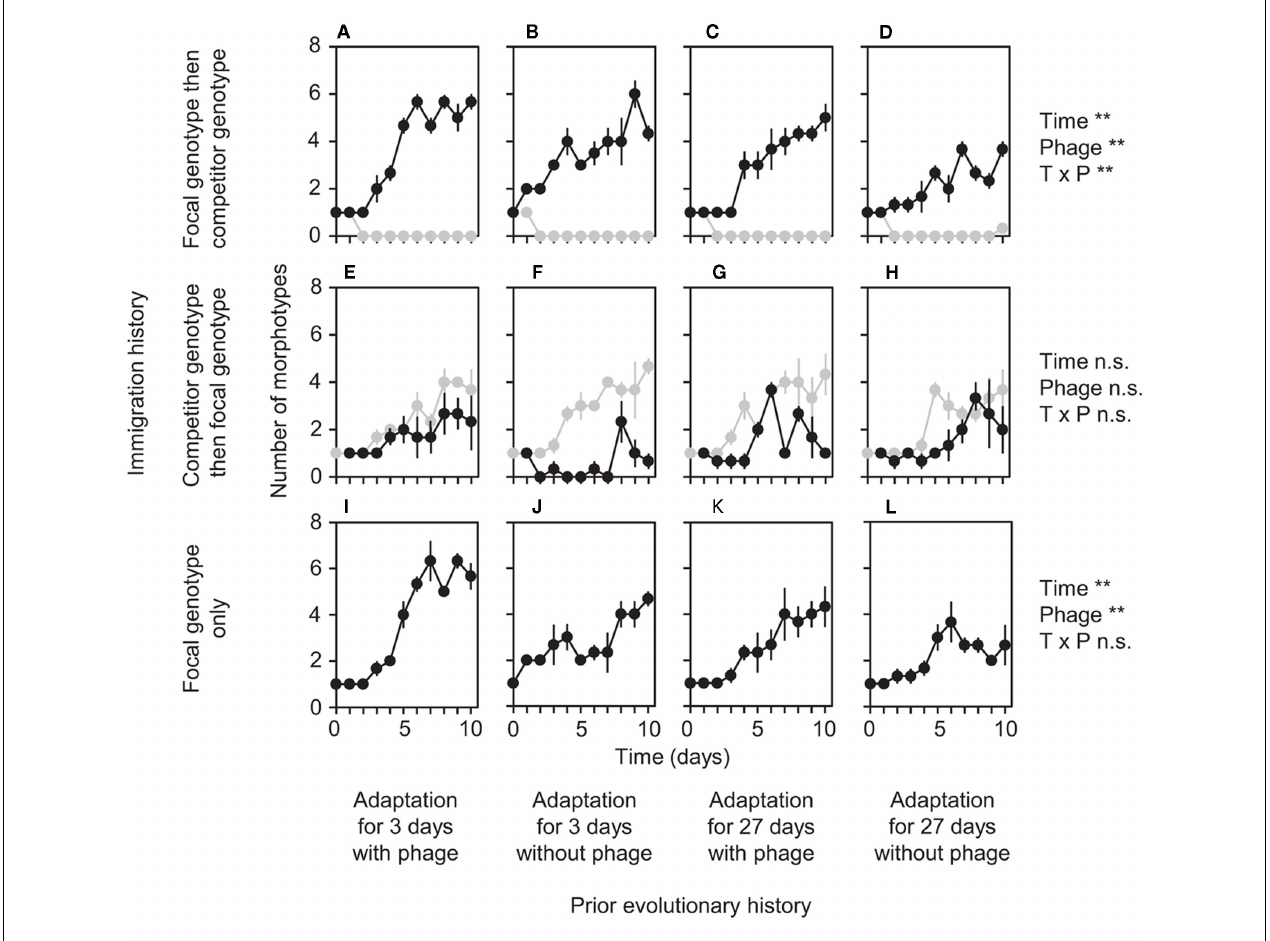
immigration history, two-way ANOVA results are indicated as follows: n.s. denotes p > 0.05, *denotes p < 0.05, and **denotes p < 0.01 (see Tables 1 – 3 ). “Time,” “Phage,” and “T × P” refer to the effect of length of time of prior adaptation, of prior evolution with phage, and of their interaction,